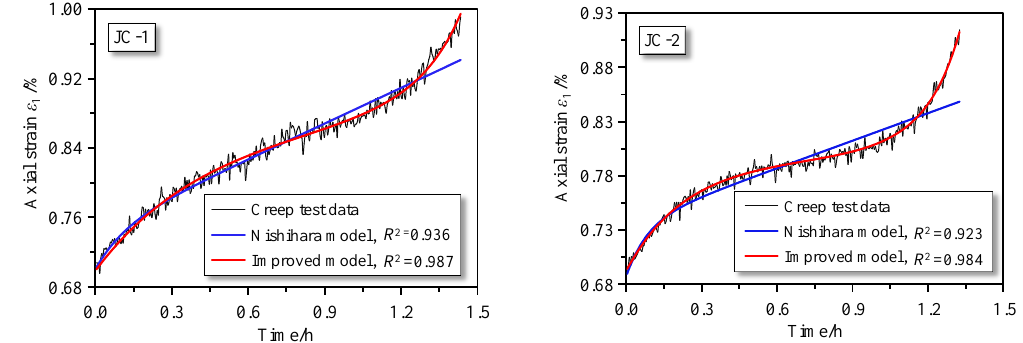
Figure 12. Comparisons between fitting curves of different creep models and experimental data.